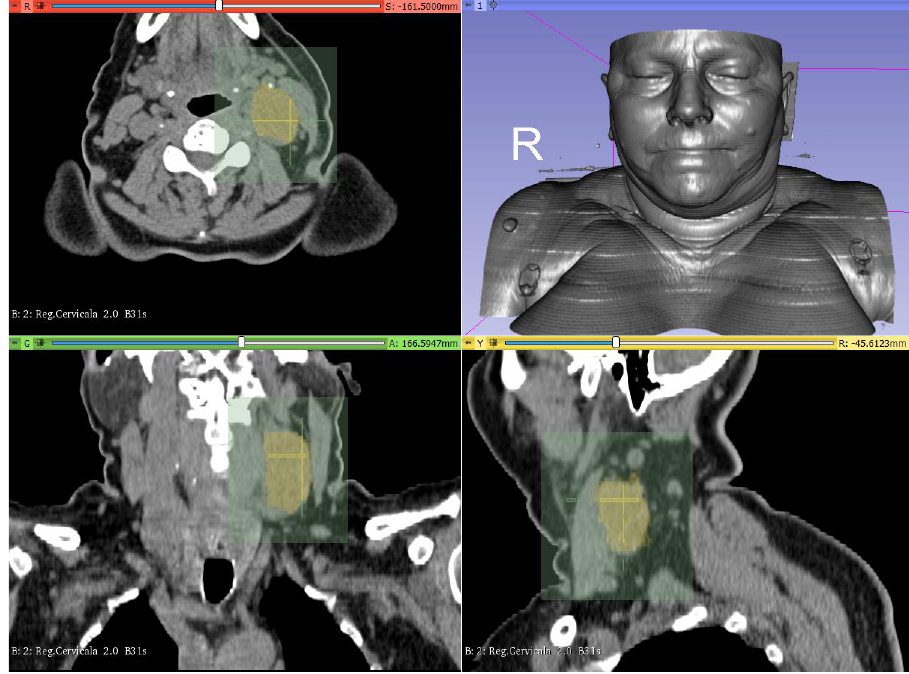
Figure 3. The abnormal cervical mass was segmented and could be clearly observed in axial (red), coronal (green), and sagittal (yellow) views. The Slicer Virtual Reality module was used to navigate inside the virtual 3D model for surgical treatment planning.